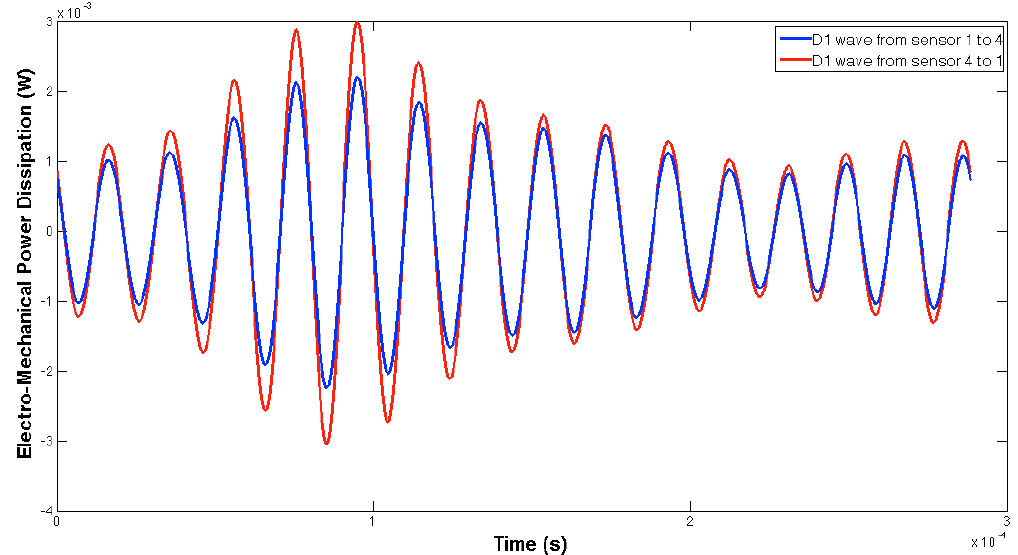
Figure 15. Differences in the EMPD in the concrete specimen for damage D1 when the wave travels opposite directions.